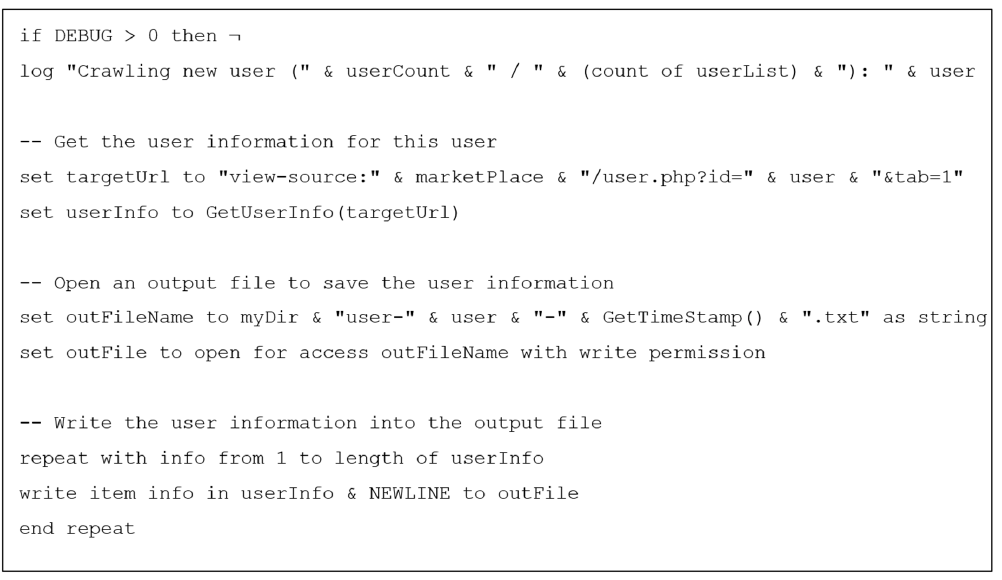
Figure A3. Sample Code Snippet for Account Scraping.